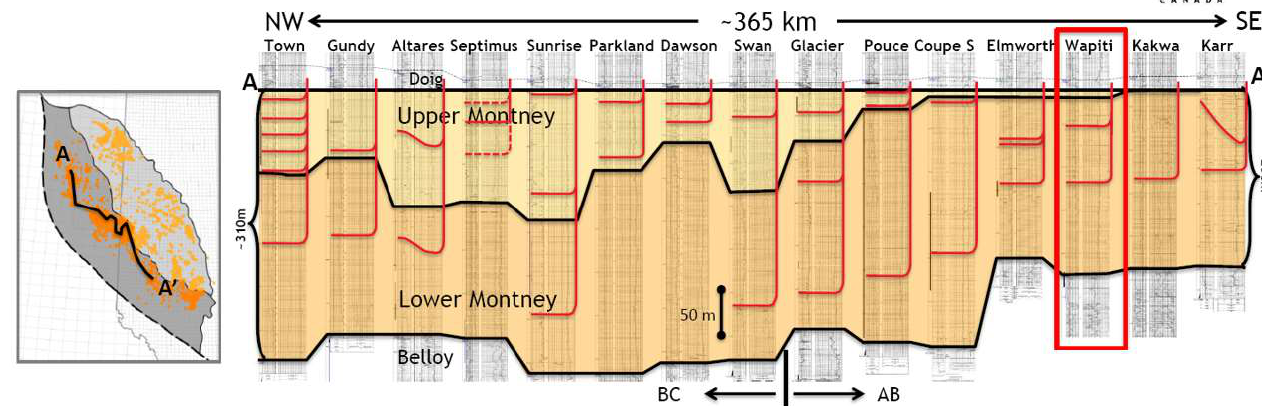
Figure 4. The Montney production fields from north to south in unconventional development area.